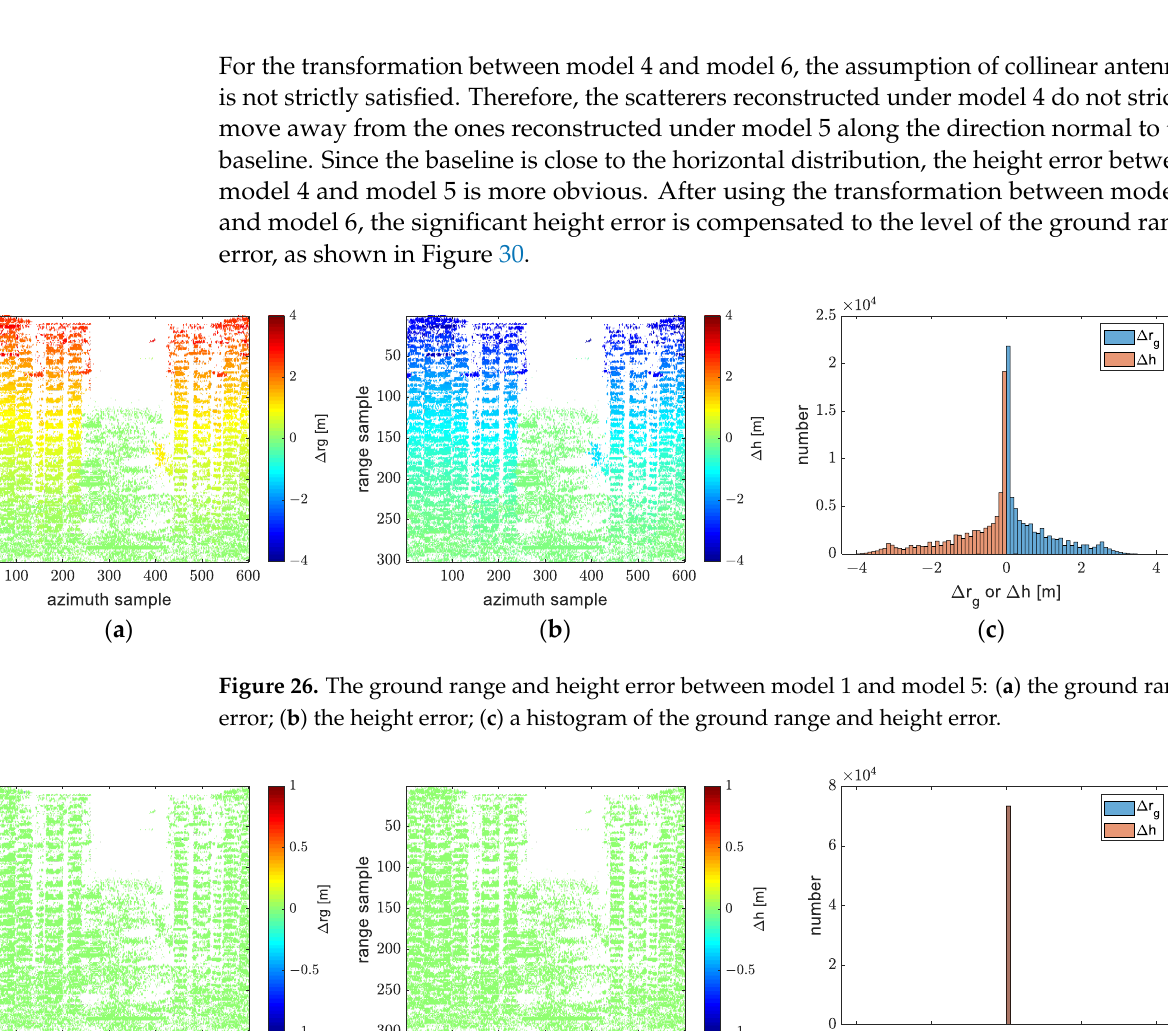
Figure 27. The ground range and height error between transformed model 1 and model 5: ( a ) the ground range error; ( b ) the height error; ( c ) a histogram of ground range and height error.